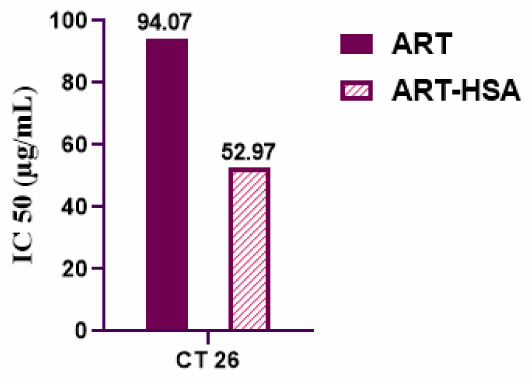
Figure 6. Comparison of the IC50 value of free artemether with encapsulated